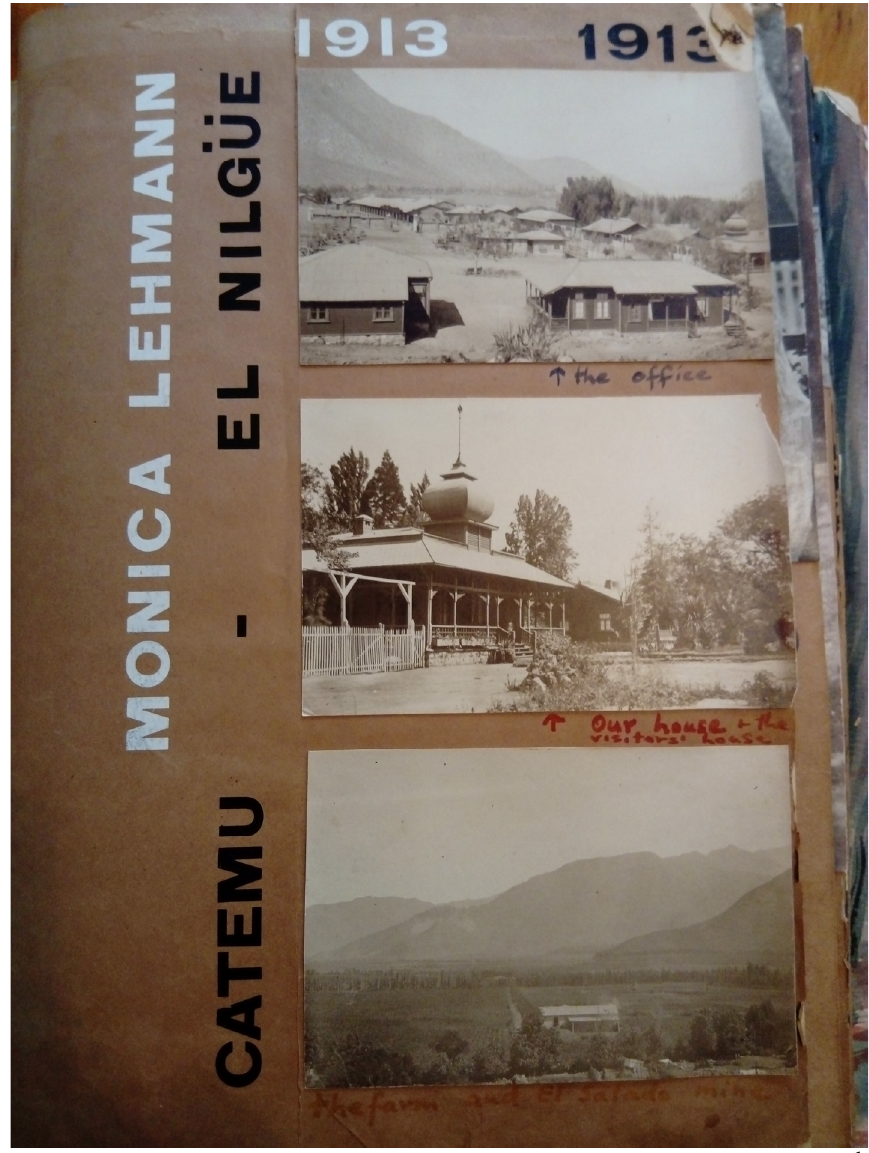
Photographs of El Ñilhue in Monica’s scrapbook (permission courtesy of Annabel